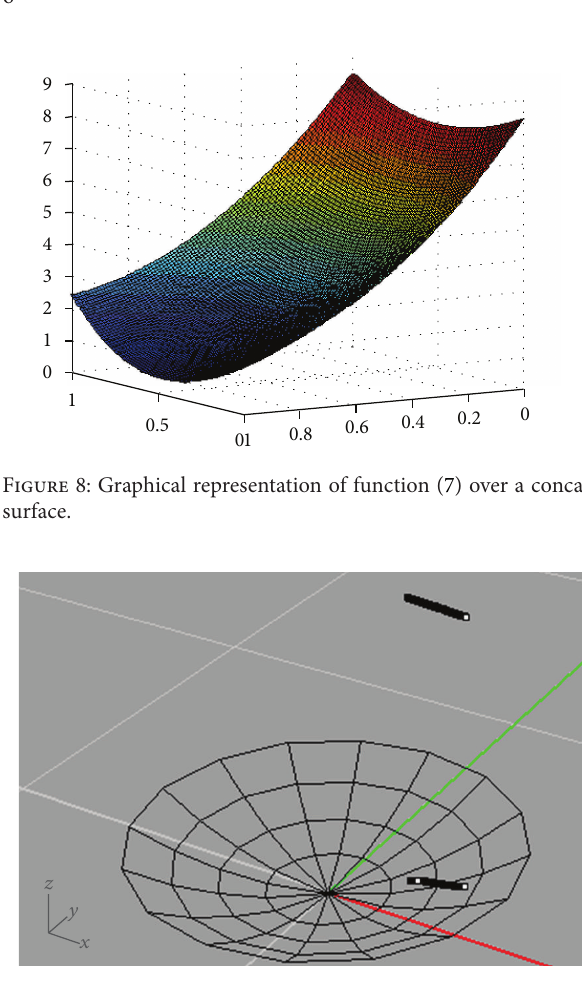
Figure 9: Perspective view of the simple reflection points obtained with function (7).